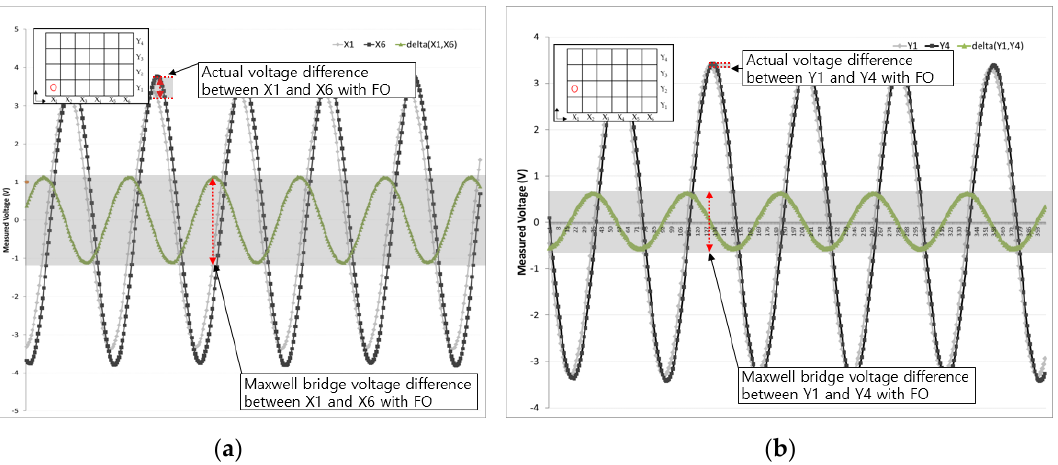
Figure 13. Voltage difference between when Maxwell bridge is used and when not used. ( a ) When a 500 KWN coin is at ( x 1 , y 1 ), and ( b ) at ( x 1 , y 2 ).